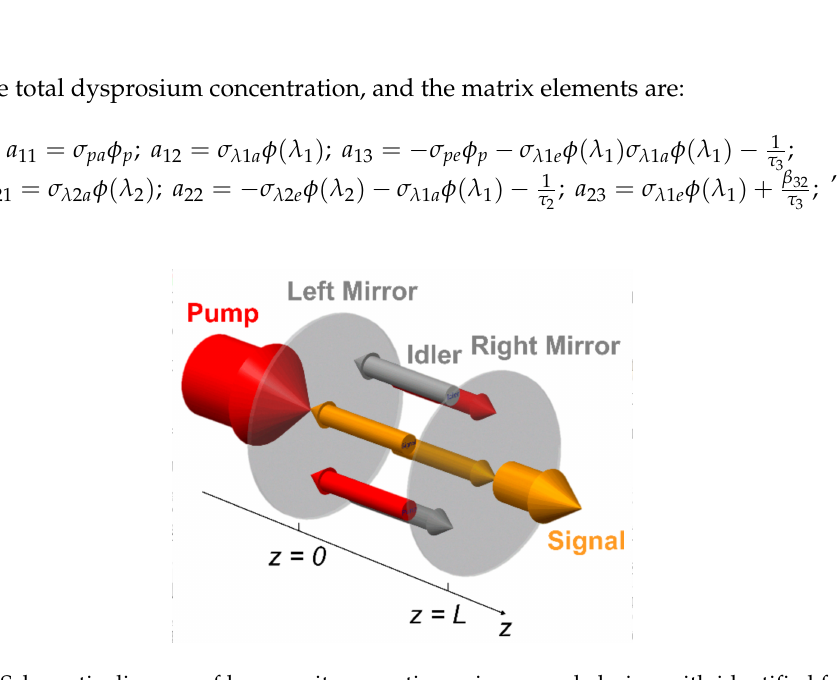
Figure 8. Schematic diagram of laser cavity operating using cascade lasing with identified forward and backward propagating pump, signal and idler